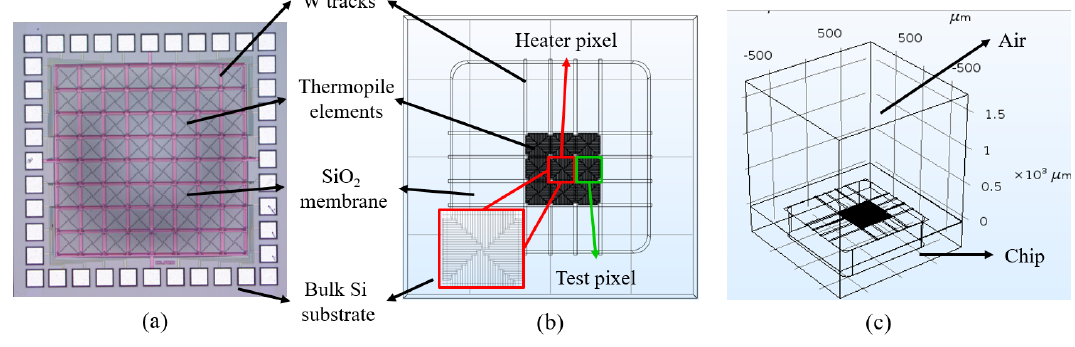
Figure 3. ( a ) Optical image of the thermopile array. Numerical model ( b ) top view and ( c ) 3D